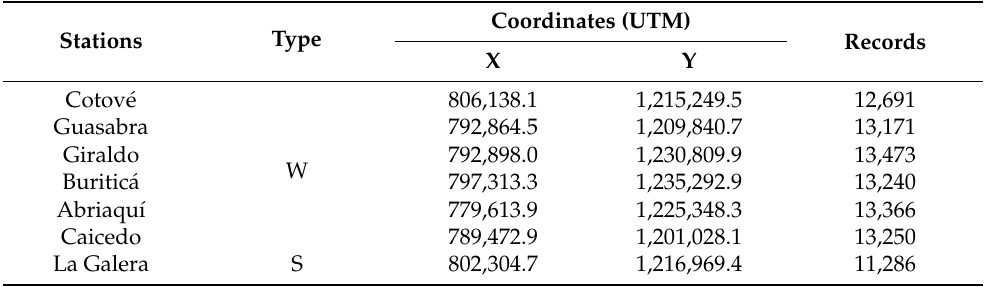
Table 1. Location details and daily records available in the period 1977–2015 of weather (W) and stream gauge (S)